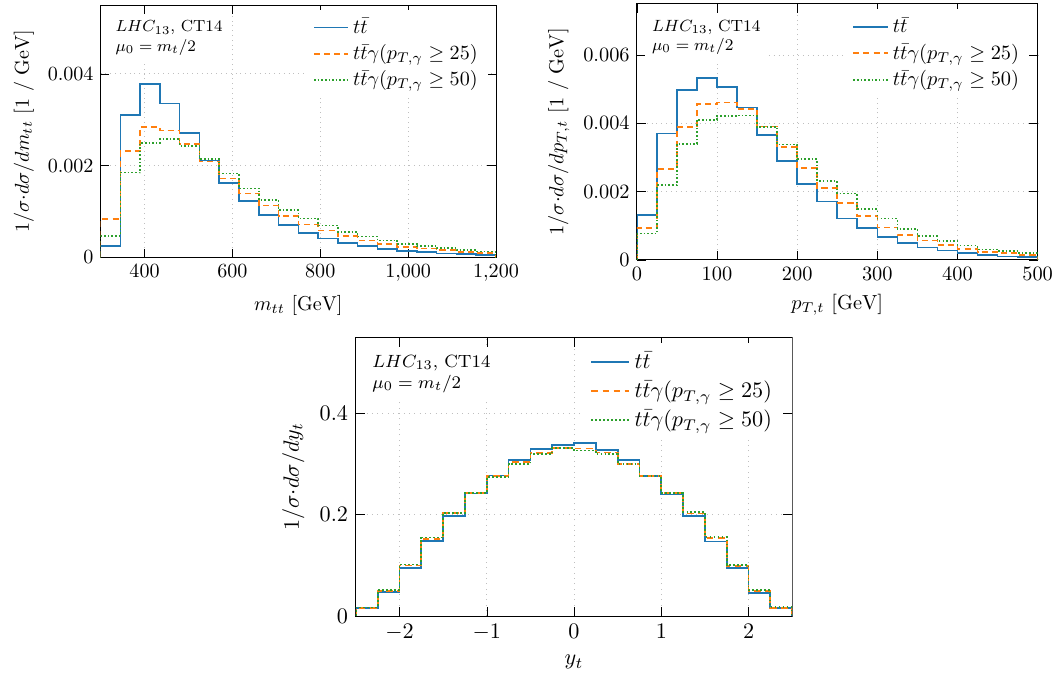
Figure 3 . Comparison of the normalised NLO di(cid:11)erential cross sections for pp and pp e + (cid:23) e (cid:22) (cid:0) (cid:22) (cid:23) (cid:22) b (cid:22) b + X at the LHC with p s = 13 TeV. The top quark kinematics is shown. ! Speci(cid:12)cally, the invariant mass of the reconstructed t (cid:22) t system ( m momentum ( p T;t ) and rapidity ( y t ) of the top quark are depicted. Results for two di(cid:11)erent values of the transverse momentum cut on the hard photon are shown. The NLO CT14 PDF set is employed and (cid:22) R = (cid:22) F = (cid:22) 0 = m t = 2 is used.